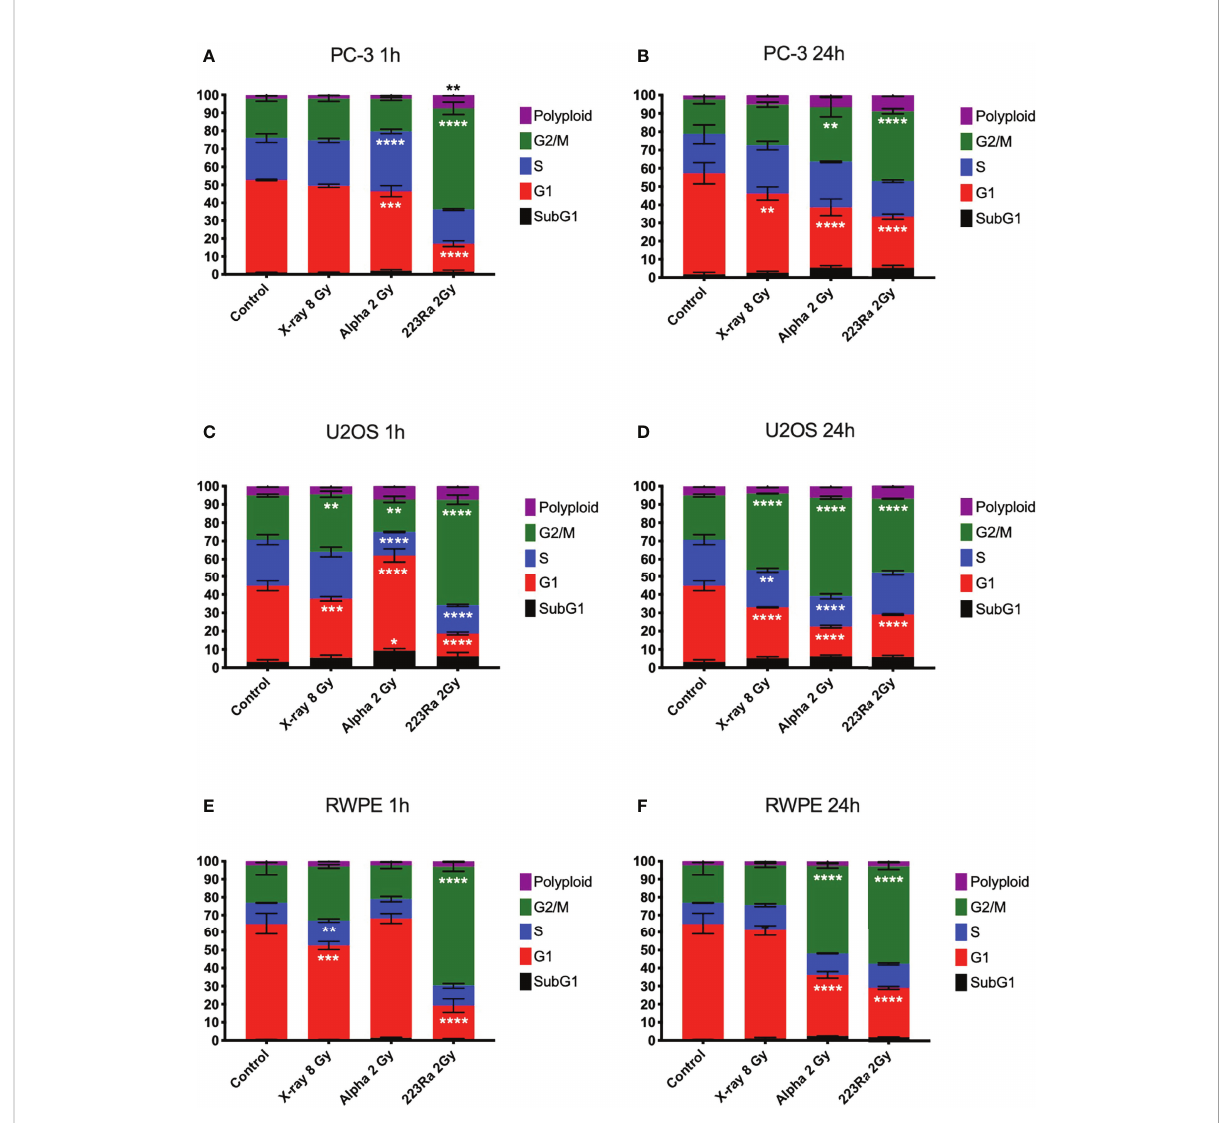
FIGURE 7 Cell cycle analysis of PC-3, U2OS, and RWPE 1 h (A, C, E) or 24 h (B, D, F) after treatment with 8 Gy of X-ray, 2 Gy of external alpha particles, or 2 Gy of 223 Ra delivered in 24 h. Bars represent the mean of two independent experiments and the respective standard error. A signi fi cant change when compared to the control group is represented by * (p < 0.05), ** (p < 0.01), *** (p < 0.001), and **** (p <